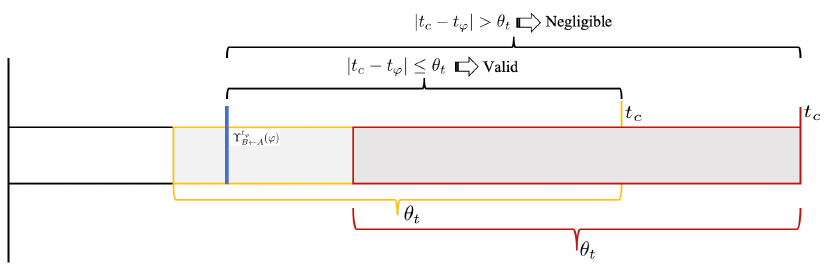
Figure 3. The design of time window for trust